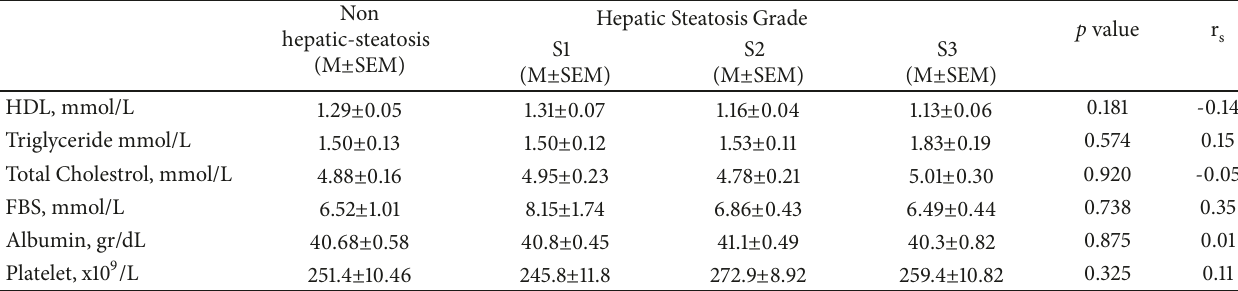
Table 3: Relationship between laboratory data and liver steatosis grade as assessed by US. HDL: high-density lipoprotein; FBS: fasting blood sugar; M: mean; SEM: standard error of means; r 𝑠 , Spearman coefficient correlation; ∗ : significant.